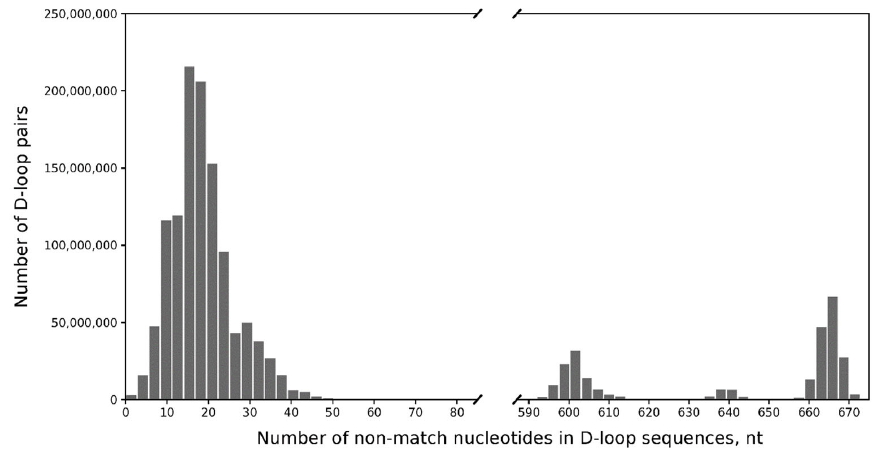
Figure 3. Distribution of mismatches and indels number in all possible pairs of D-loop sequences from the GenBank collection of 55,180 mitochondrial genomes.